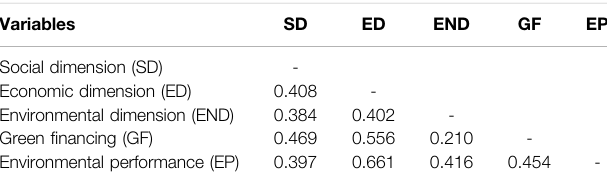
TABLE A1 | Heterotrait – Monotrait ratio (HTMT).